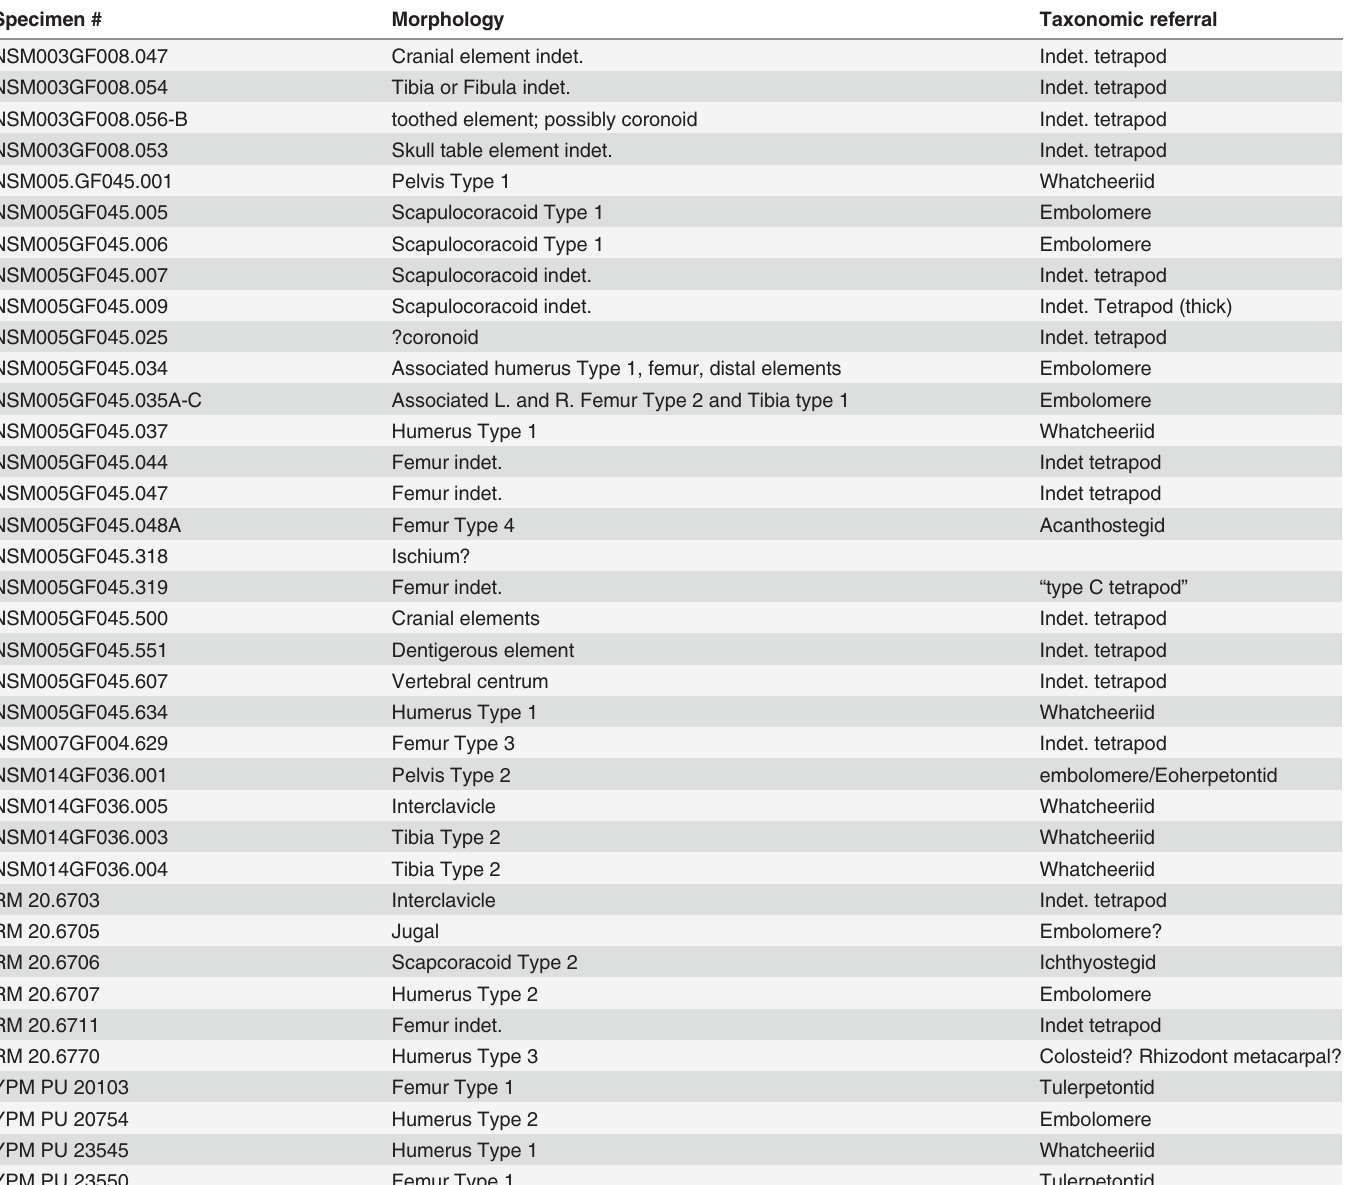
Table 1. List of Blue Beach specimens examined in the present